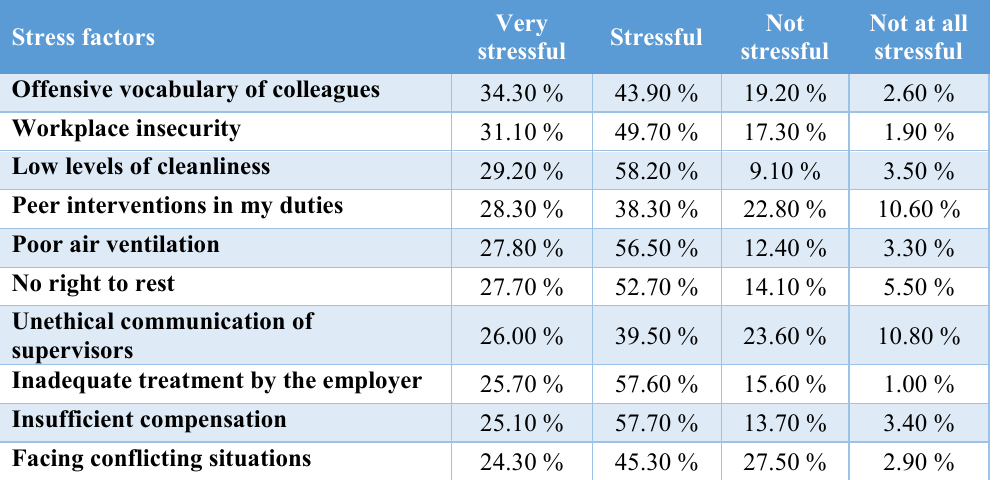
Table 1. The Most Stressful